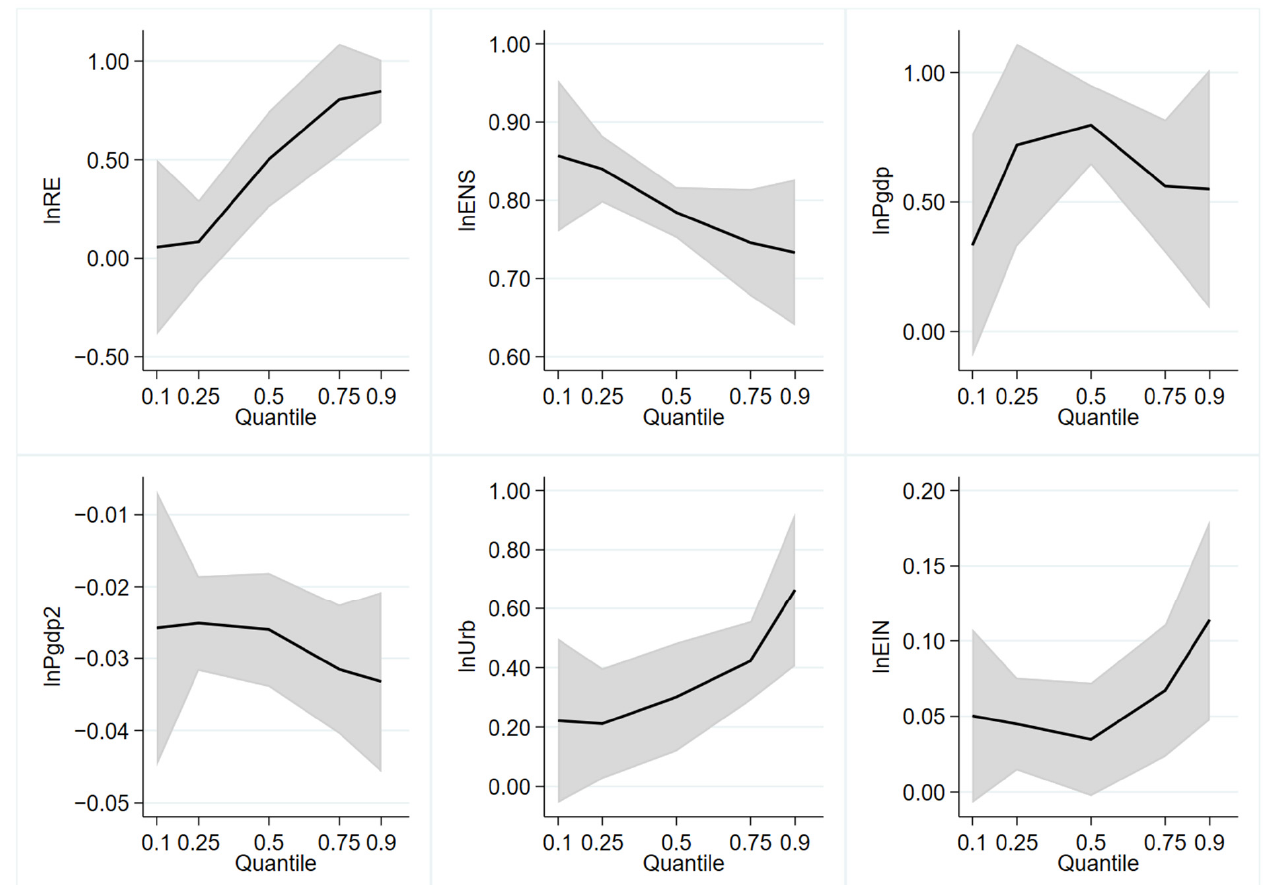
Figure 8. Coefficient change for each variable in two-step quantile regression.